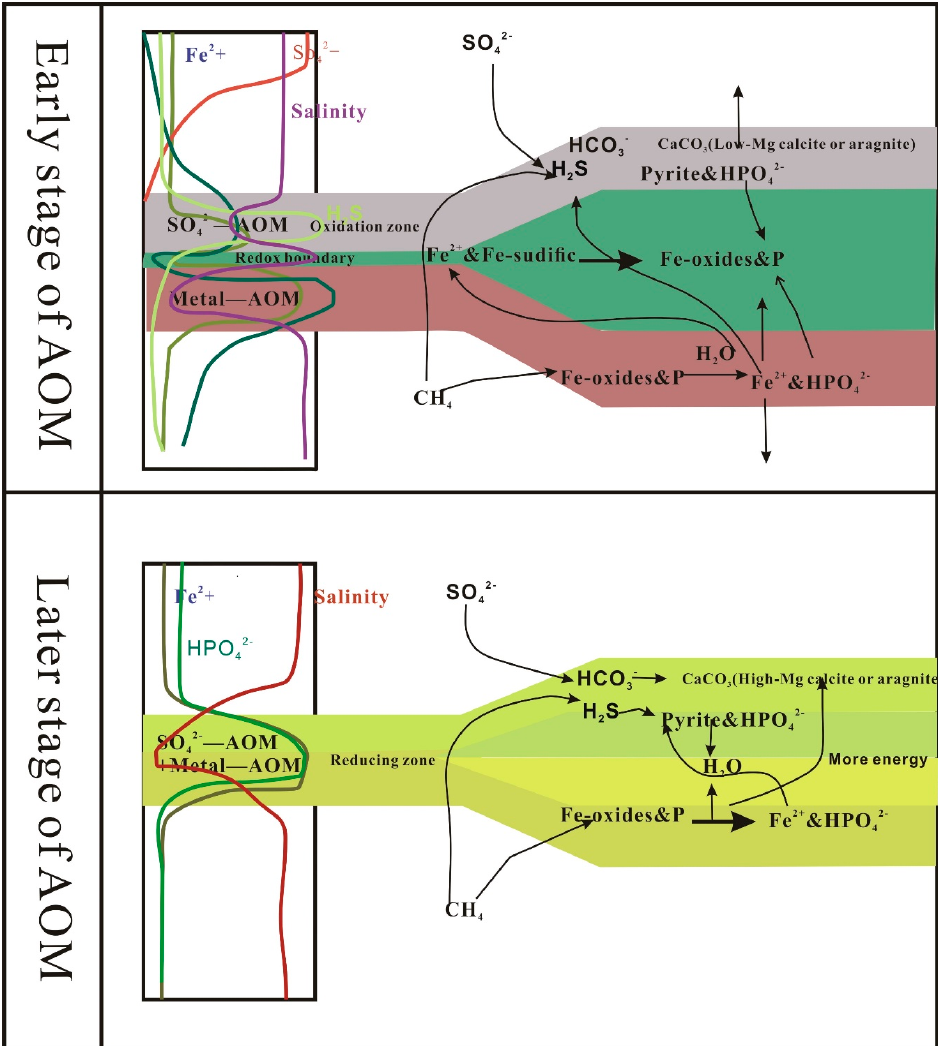
Figure 6. In the early AOM stage of AOM, SO 4 2 − and CH 4 were coupled to form a sulfide environment in the SMTZ layer, and the pore water was enriched in H 2 S. At the same time, the in situ metal oxide was converted into metal sulfide in the SMTZ, creating magnetic properties in the sediment relative decline. Adsorption on the metal oxide surface was also released into the pore water, resulting in the enrichment of a large amount of HPO 4 − . The presence of a low sulfate and anoxic environment at the bottom of the SMTZ horizon was dominated by metal-AOM, which converted large amounts of metal oxides and hydroxides into metal ions. Metal ions diffused upwards, some were reoxidized to oxides at the redox boundary, and most continued to move upwards and provided a source of ions for the formation of metal sulfides in the shallow part. A large amount of water was generated during metal AOM. Water caused pore water salinity to decrease, and nutrients such as nitrogen and phosphorus adsorbed on the surface of the metal oxide were also enriched in the pore water and diffused upward, while some were re-adsorbed and precipitated at the redox boundary. In the later AOM stage, the sulfate-driven AOM action and the metal AOM action occurred simultaneously in the SMYZ layer. The two functions converted metal oxide into metal sulfide, the metal ion provided by metal-AOM, and part of the metal formation. Sulfides provided a source of metal ions and some formed in situ an